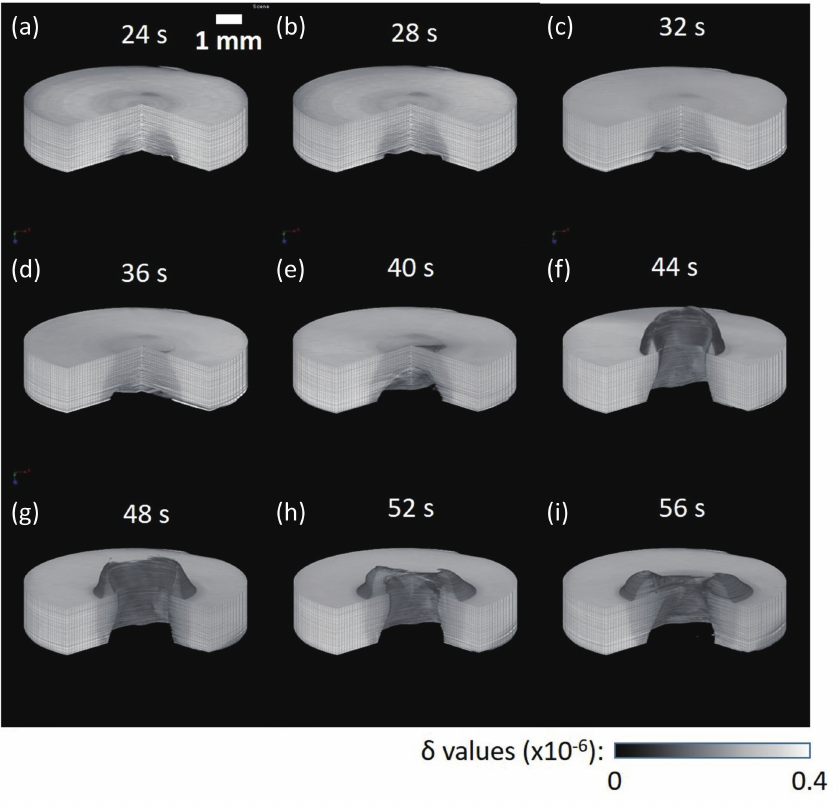
Figure 6. Three-dimenstional rendering views of the 4D phase tomograms obtained for the polypropylene sample at different laser irradiation times [63]: ( a ) 24 s, ( b ) 28 s, ( c ) 32 s, ( d ) 36 s, ( e ) 40 s, ( f ) 44 s, ( g ) 48 s, ( h ) 52 s, and ( i ) 56 s.